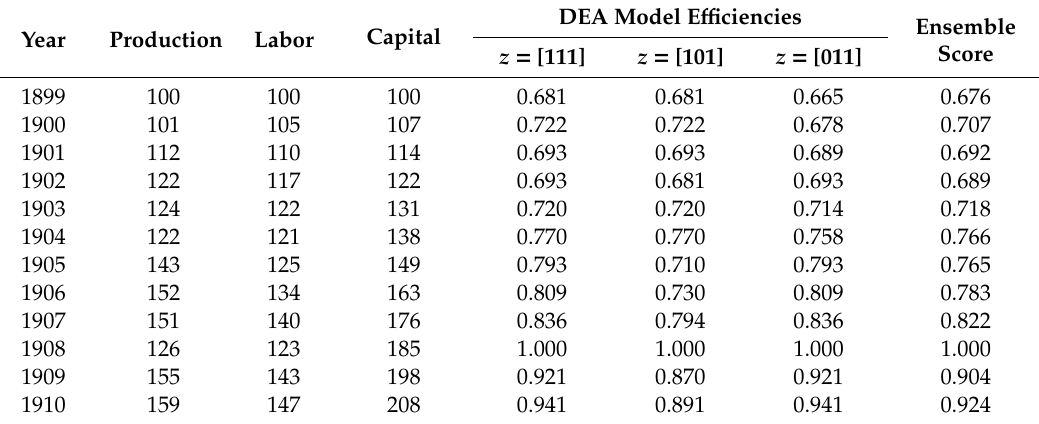
Figure 1. Exhaustive Search Tree for possible unique combinations of two-input-one-output datasets. Table 1. Ensemble data envelopment analysis (DEA) scores for 1899–1910 US economic growth data.